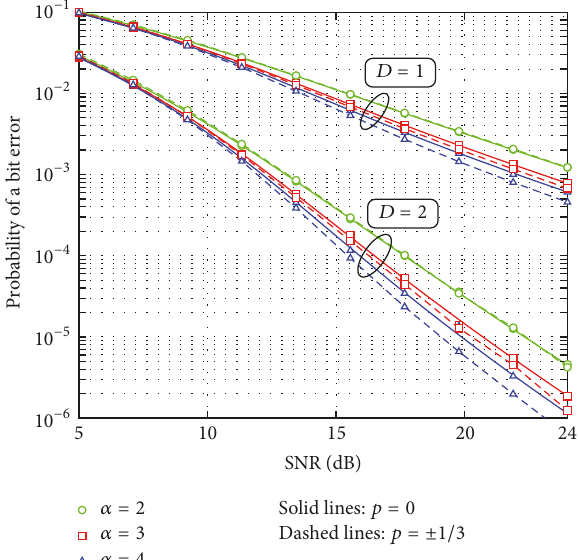
Figure 8: Average BER against SNR for single and dual channel diversity reception with 𝜇 = 3 and 𝐿 = 3 for balanced and unbal- anced